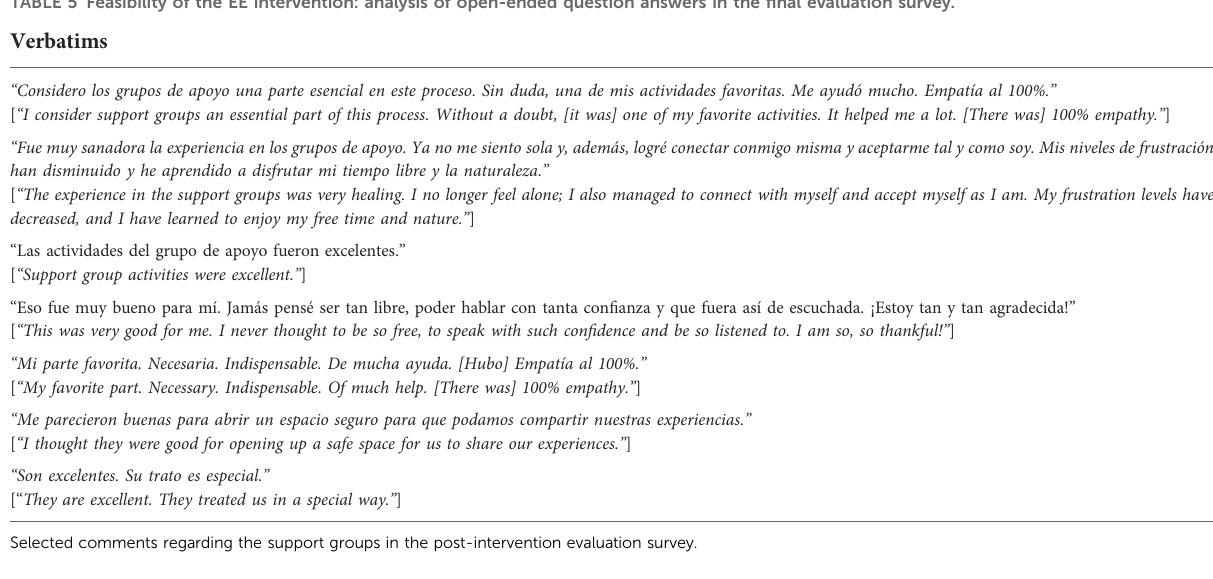
TABLE 6 Feasibility of the EE intervention: analysis of 3-month after the end of the intervention group discussion transcripts. Theme Verbatim